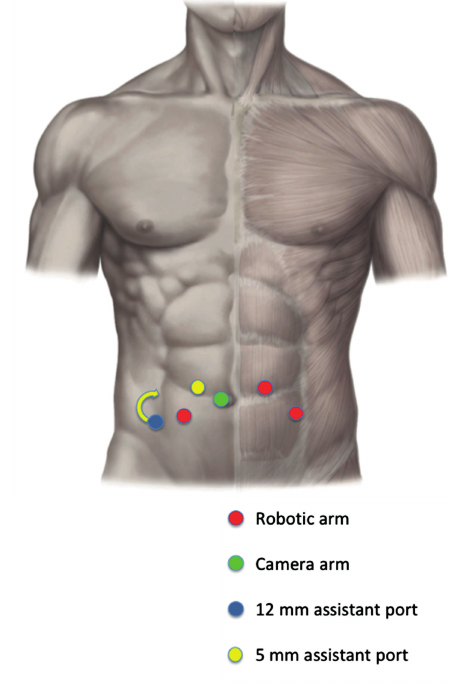
The placement of the 12 mm assistant port was modifi ed, medially and cranially respect to the standard set, in case of right kidney graft location.